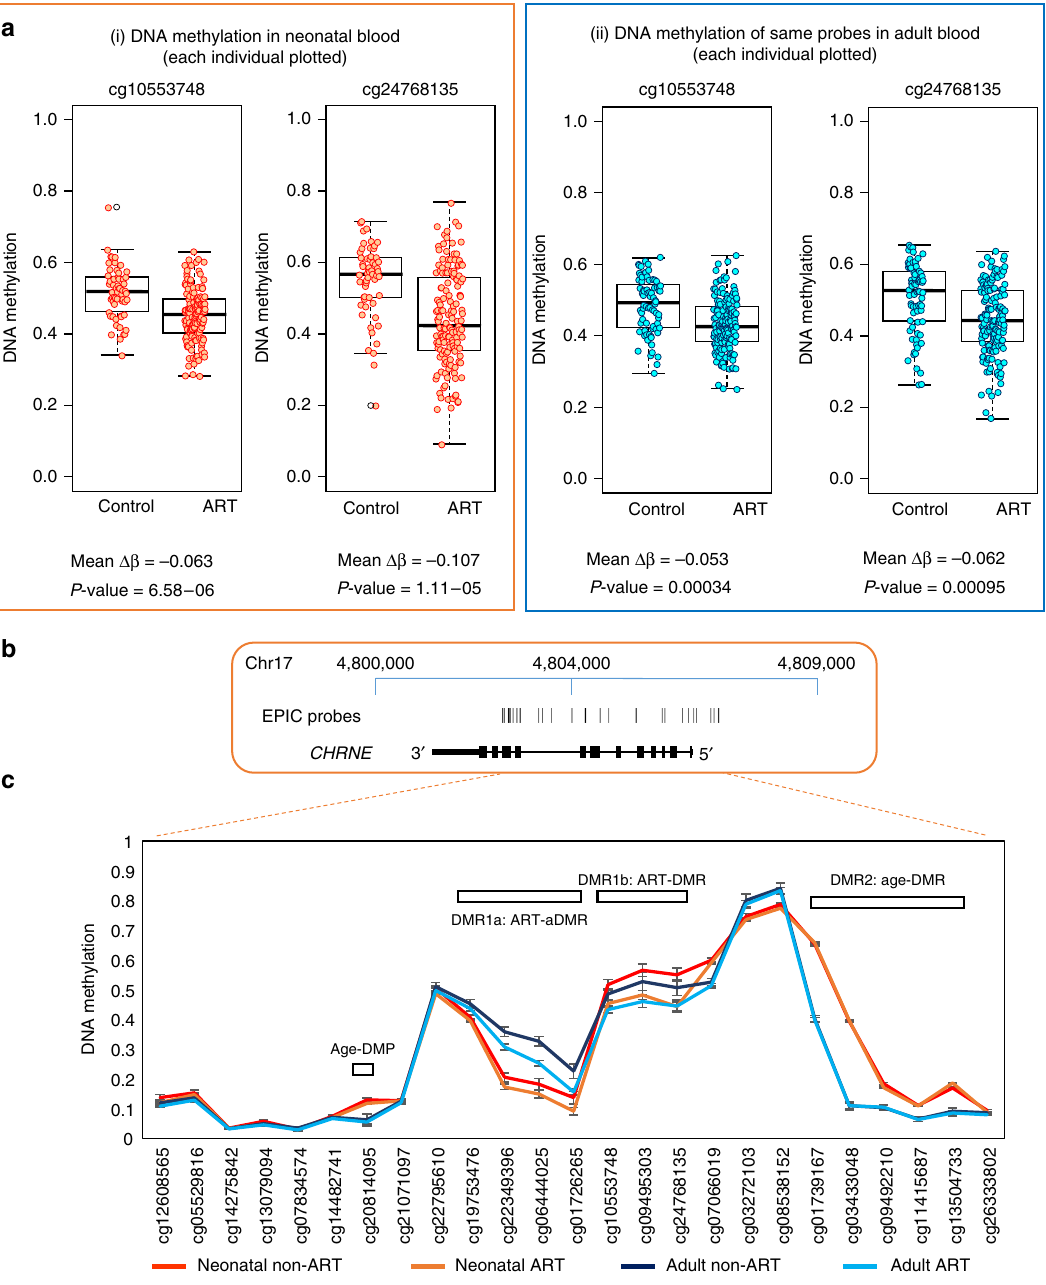
Fig. 3 Detailed DNA methylation map of the CHRNE gene. a (i) Boxplot and dot-plot of DNA methylation for individual neonatal control and ART samples at the two probes within the CHRNE gene that showed a signi fi cant difference between groups (adjusted p -value <0.05 (Bayesian levene ’ s test)). n = 207 biologically independent birth samples, n = 233 biologically independent adult samples. (ii) Boxplot and dot-plot of the same two probes in individual adult control and ART samples. The change is no longer signi fi cant in adult samples after correction for multiple testing, but the direction of methylation change persists. Boxplot elements are: center line-median; box limits-upper (Q3) and lower (Q1) quartiles; whiskers – smallest and largest non-outlier; points- outliers. b . Map of the CHRNE gene in hg19, showing EPIC probe locations. c Mean DNA methylation level at CHRNE for neonatal and adult non-ART and ART groups. Error bars are 95% con fi dence intervals. DMR1 is split into two: DMR1a that shows both ART and age speci fi c DNA methylation differences and DMR1b that only shows ART-speci fi c DNA methylation change. In addition, an age-speci fi c DMR (DMR2) and a DMP are